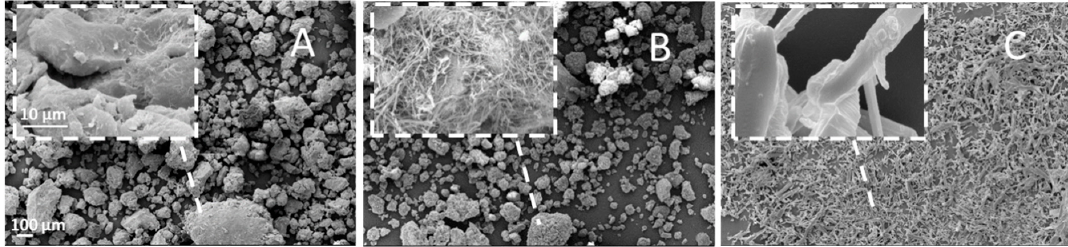
Figure 1. SEM images of PZQ:PVP CC ( A ), PZQ Form B ( B ), and raw PZQ ( C ) (magnification 150 × ; in the top left frame a 5.0 K × magnified image).